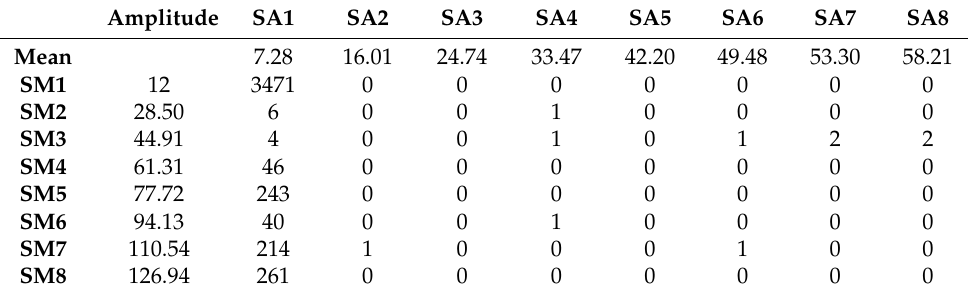
Table 5. Load spectrum compiled based on real